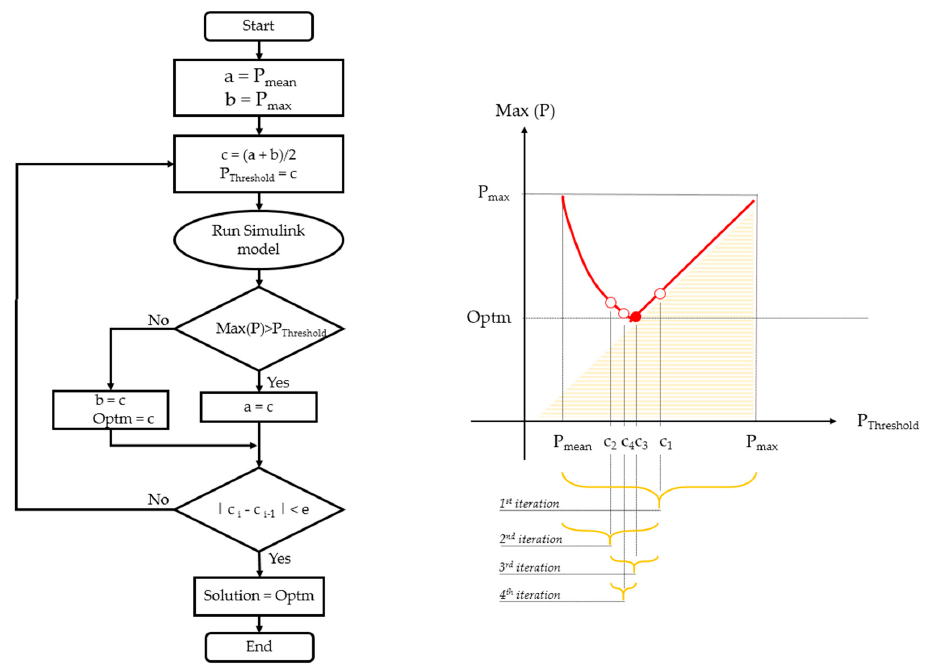
Figure 5. Flow chart—Dichotomy method: ( a ) Pseudocode (left), ( b ) Midpoint evolution (right).